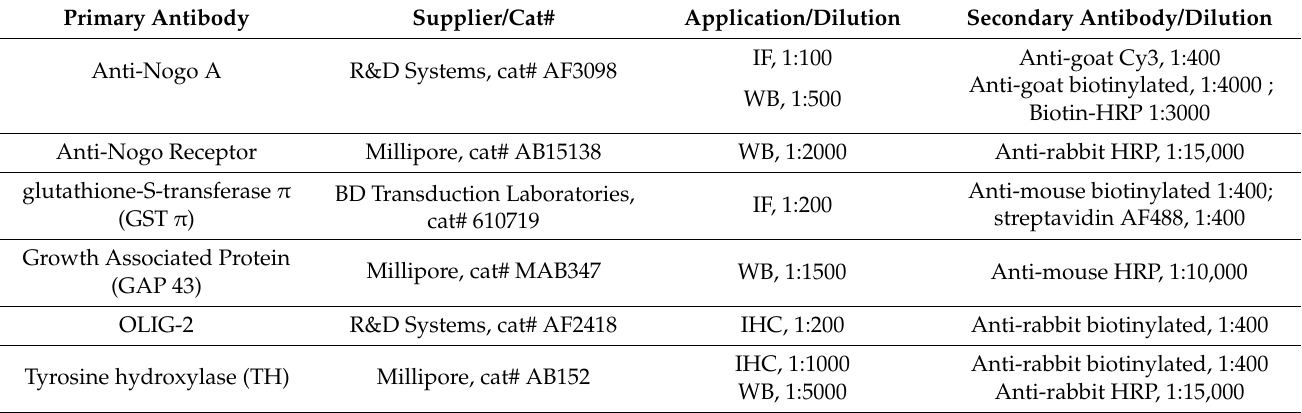
Table 1. List of primary and secondary antibodies used for Western blot (WB), Immunofluorescence (IF) and Immunohisto- chemistry